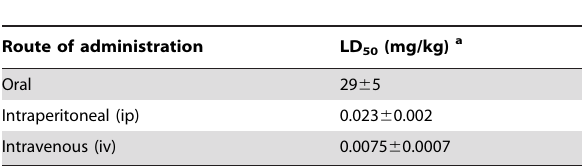
Table 1. LD 50 of pure ricin in mouse toxicity